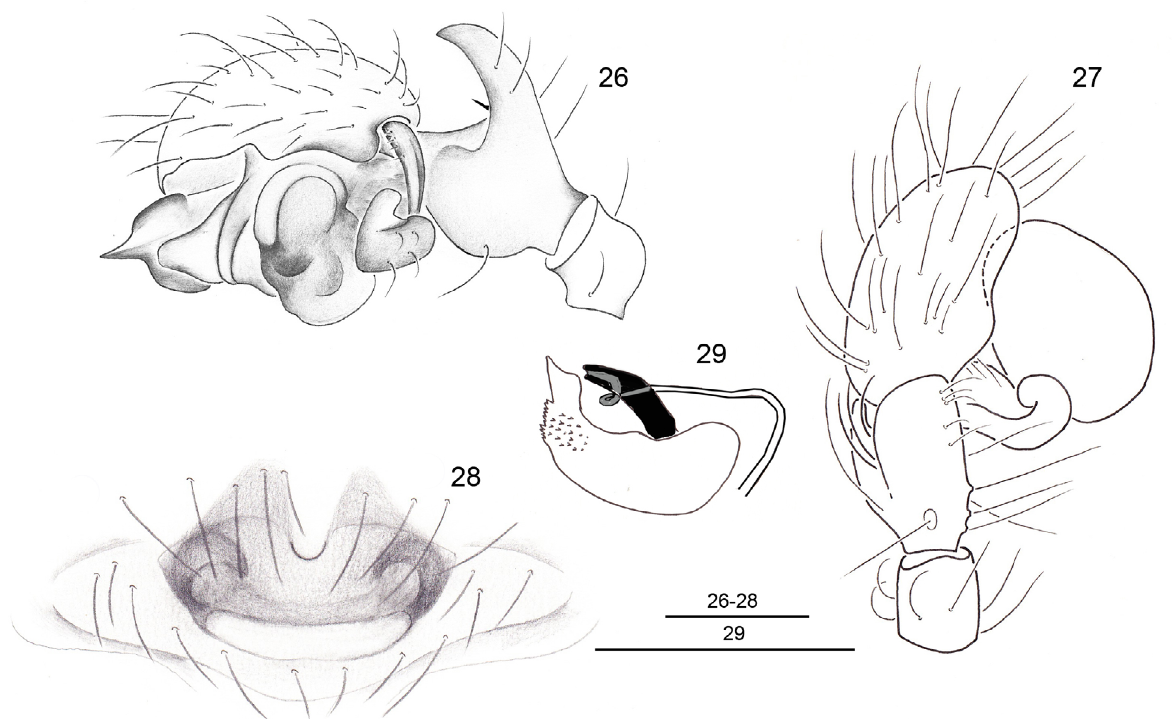
Figs 26-29. Holmelgonia afromontana sp. nov. (♂ holotype, ♀ paratype 227154). 26 . Palp, ♂, retrolateral view. 27 . Palp, ♂, dorsal view. 28 . Epigyne, ventral view. 29 . Embolic division of ♂ palp, ventrolateral view. Scale bars = 0.1